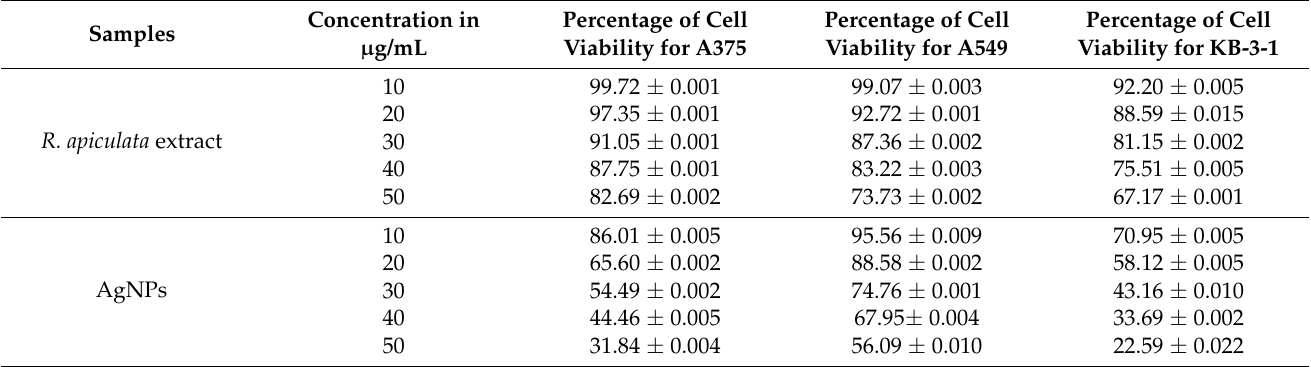
Table 8. Anticancer activity of R. apiculata and its synthesized AgNPs against different cancer cell